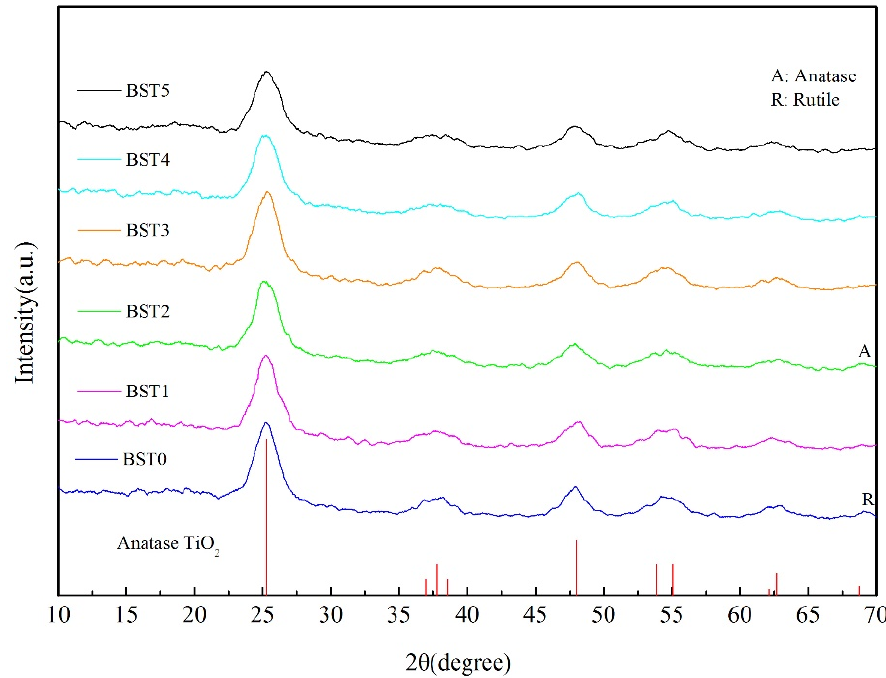
Figure 5. The XRD spectrum of Si–Ti composite film prepared at different Bi-doped amounts. Table 1. The average crystal grain size of Bi-Ti/Si-X composite film. Table 1. The average crystal grain size of Bi-Ti/Si-X composite film.